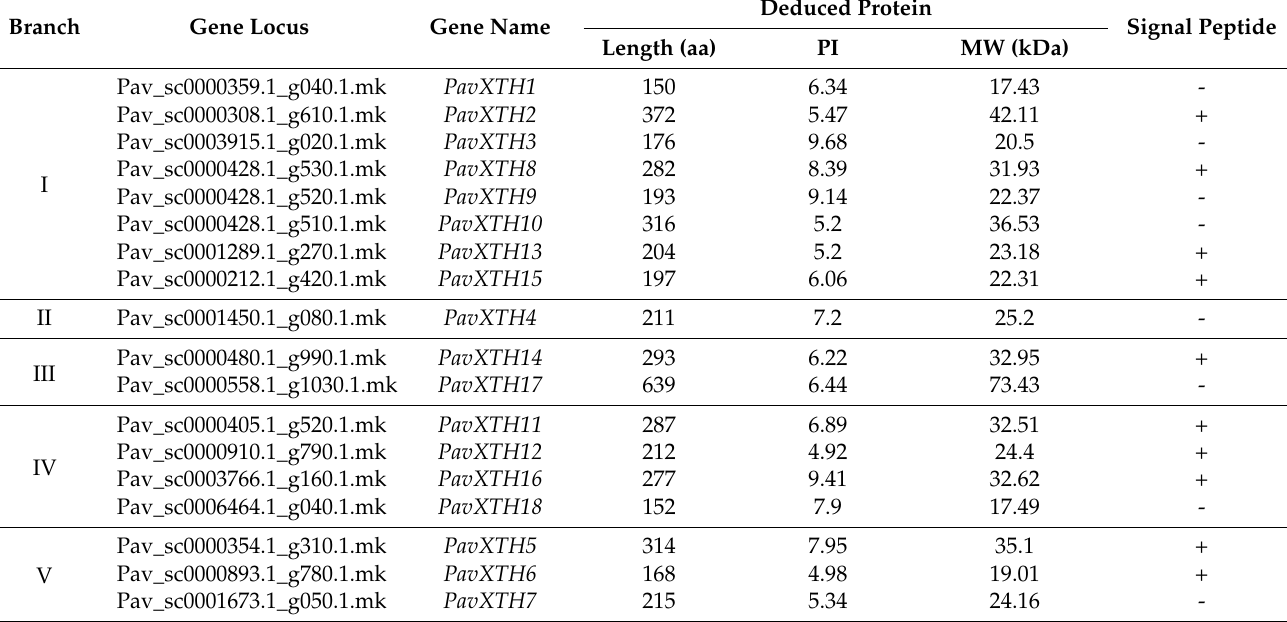
Table 1. XTH genes identified in Sweet